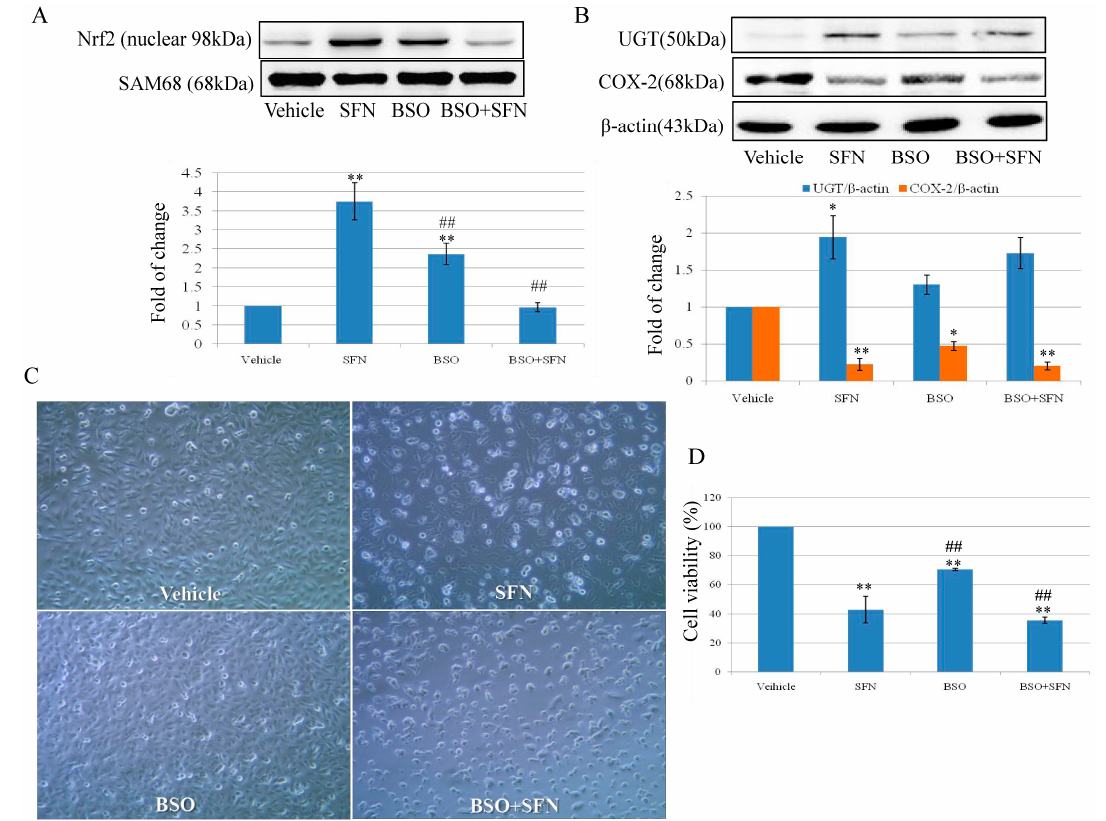
Figure 5. Effect of SFN on the expression of Nrf2 and UGT and cell viability by targeting γ -GCS. T24 cells were incubated with SFN 10 µM and BSO 200 µM in co-treatment and separately for 24 h. Cells were treated with 0.1% DMSO as control. ( A ) Nrf2 nuclear expression in T24 cells exposed to BSO and SFN. SAM68 was used as a loading control. ( B ) UGT and COX-2 expression in T24 cells exposed to BSO and SFN. β -actin was used as loading control. ( C ) After treatment with BSO or SFN, cells were photographed with a microscope (×100). ( D ) After treatment with BSO or SFN, T24 cell viability was determined by MTT cell proliferation assay. ** P < 0.01 is represented with a significant difference compared with untreated cells (the Vehicle group). Statistical significance versus SFN treatment: # P < 0.05, ## P < 0.01.